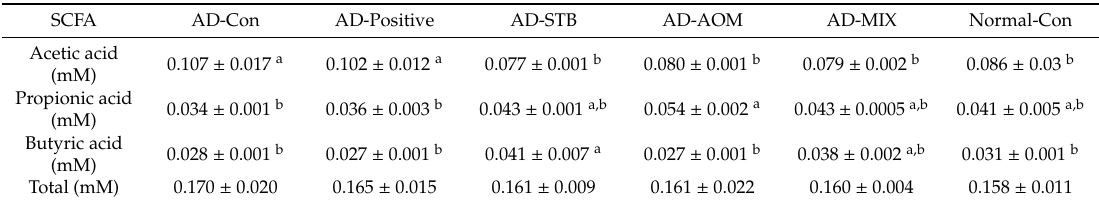
Table 3. Short-chain fatty acids (SCFA) concentration in portal venous serum. SCFA AD-Con AD-Positive AD-STB AD-AOM AD-MIX Normal-Con Acetic acid